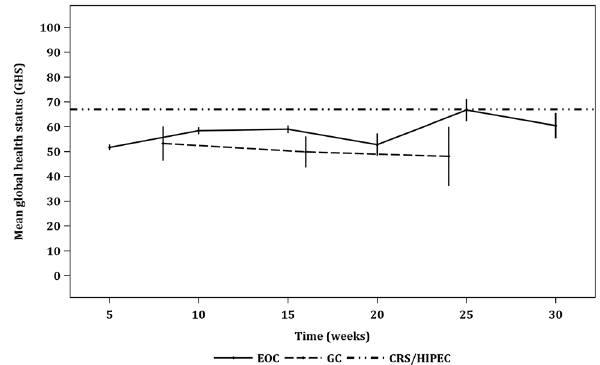
Figure 2: Line graph depicting the global health status (GHS) scale of QoL as measured by EORTC QLQ-C30 across time. The three-point trendline depicts GHS scores before the first, second, and third cycles of PIPAC (c) in patients with peritoneal metastasis (PM) from gastric cancer (GC); c1=31, c2=22, c3=5. The six-point trendline depicts GHS scores before the fi rst, second, third,fourth, fi fth,andsixthcyclesof PIPACinpatientswithPMfrom epithelial ovarian cancer (EOC); c1=104, c2=70, c3=50, c4=9, c5=6, c6=4. Error bars represent 95% CI. No signi fi cant difference was found comparing means within GC and EOC. As a reference, the dashedlinerepresentsasnapshotofGHSin6 – 18monthsafterCRS/ HIPEC in a cohort of patients (n=27) with PM from a mixed histological